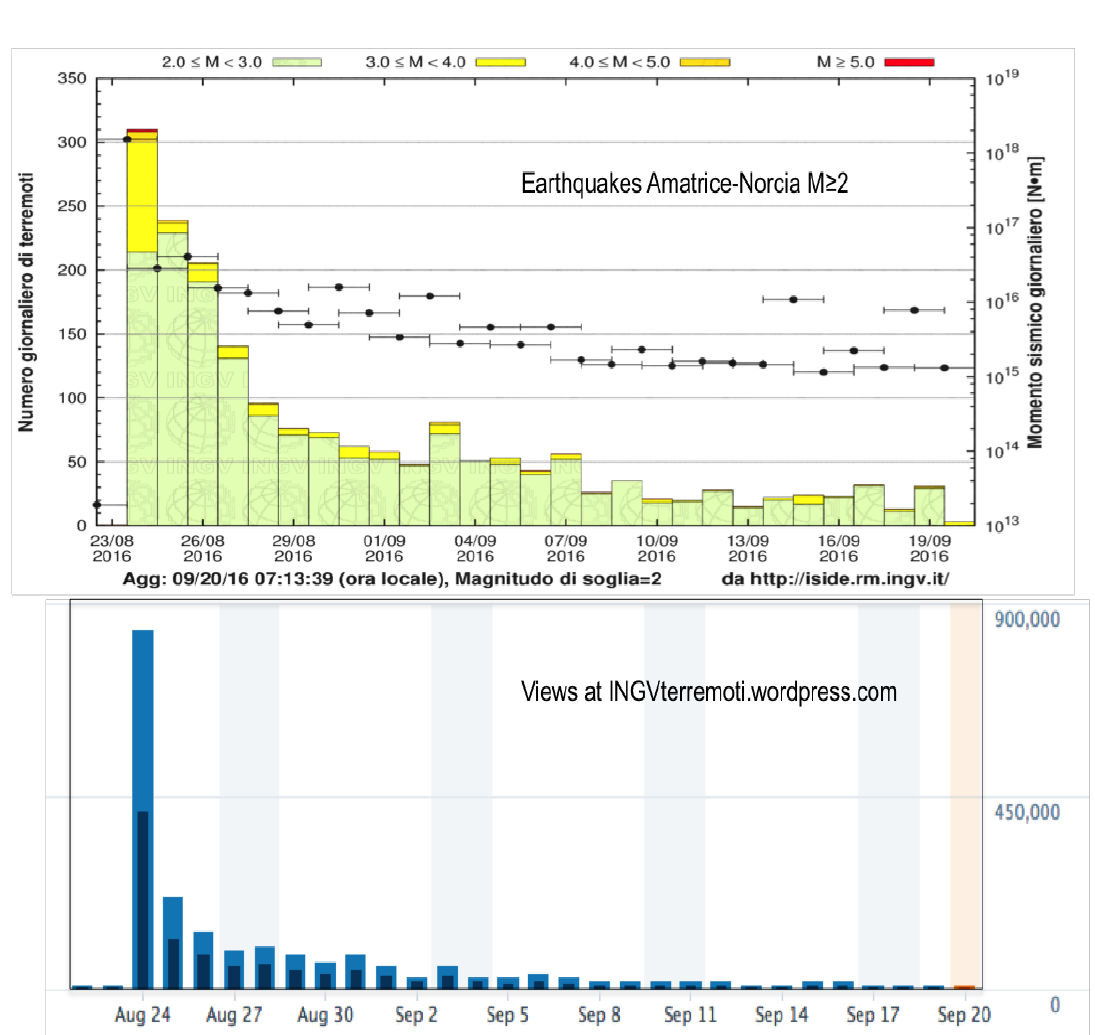
Figure 3: Comparison between the daily number of earthquakes and views (light blue, visitors are in blue) of the INGVterremoti blog, from August 22, 2016 to September 20, 2016. In August 24 there is the peak in the number of views (829,503) and visitors